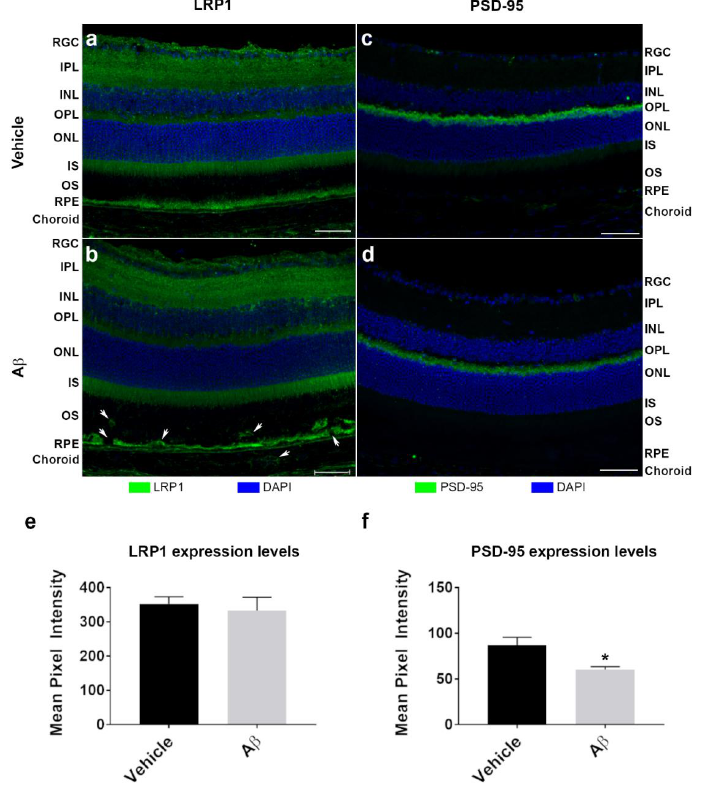
Figure 4. Effects of subretinally injected A β on LRP1 and PSD-95 expression in mouse retinas at two weeks post-injection. Mouse eyes injected with human oligomeric A β 1-42 ( n = 3) or vehicle ( n = 3) were analyzed to determine potential changes to expression of the A β clearance receptor LRP1 and the post-synaptic density marker PSD-95. Two weeks after subretinal injections, animals were culled and ocular cross-sections assessed by confocal immunofluorescence microscopy. ( a ) Representative image shows LRP1 expression in vehicle-injected eye compared to ( b ) eye injected with A β . Note, how staining reveals evidence of disrupted OS, RPE/BrM and choroid after A β exposure (arrows). ( c ) Representative image shows PSD-95 expression in vehicle-injected eye compared to ( d ) eye injected with A β . Structure of the OPL and adjacent layers of the neuroretina appears to be unaffected by subretinal A β exposure. Scale bars correspond to 50 mm. ( e – f ) The mean pixel intensity was quantified for all layers (retina, RPE/BrM and choroid) and presented as a combined value for each treatment. No changes was observed in LRP1 expression between A β and vehicle-injected eyes (unpaired Student’s t -test, p = 0.67, two tailed). By contrast, expression of PSD-95 was significantly diminished 2 weeks after A β treatment compared to control eyes ( p = 0.04, two tailed). Error bars represent S.E.M. * denotes a significance of p <